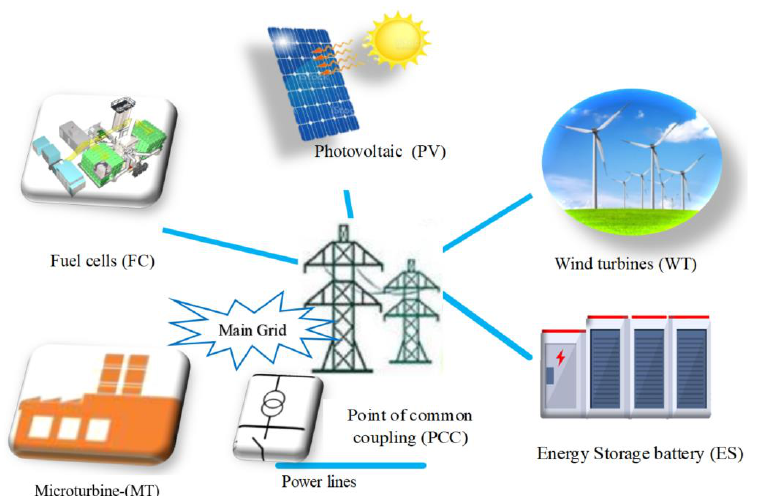
Figure 1. A typical structure of a microgrid with power sources distribution.